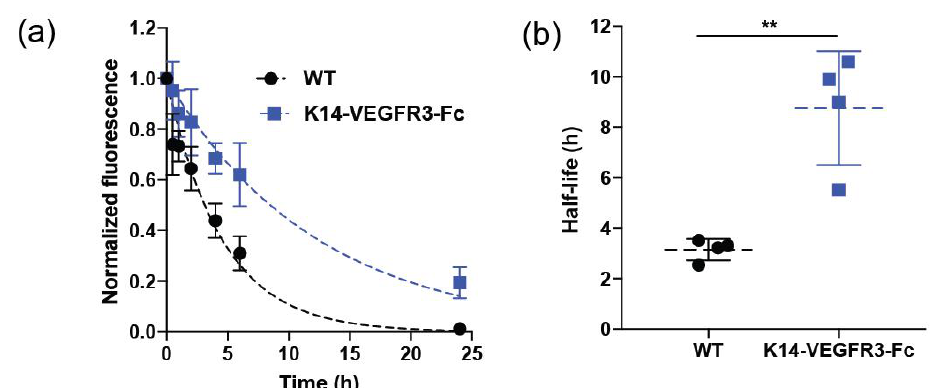
Figure 2. Quantification of dermal lymphatic drainage after bolus intradermal administration of 3 µL of ICG (0.0025 mg/mL) in 5% HSA in the ears of WT and K14-VEFGR3-Fc mice lacking a dermal lymphatic vasculature. ( a ) Normalized fluorescence intensity over time and fitting of mono- exponential decay function in WT and K14-VEGFR3-Fc ( n = 4 mice per group) mice. ( b ) Quantification of dermal elimination half-lives in WT and K14-VEFGR3-Fc mice from fitted curves. Data are shown as mean ± S.D and compared by Student’s t-test; ** p < 0.01.